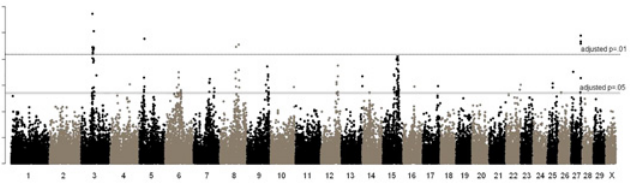
Fig 1. Manhattan plot of BovineSNP50 marker association tests with transformed mean FEC. Each dot indicates significance level ( – log 10 p) of an association for BovineSNP50 marker relative to its UMD 3.1 genome coordinate. Suggestive and significance thresholds are described in the Materials and